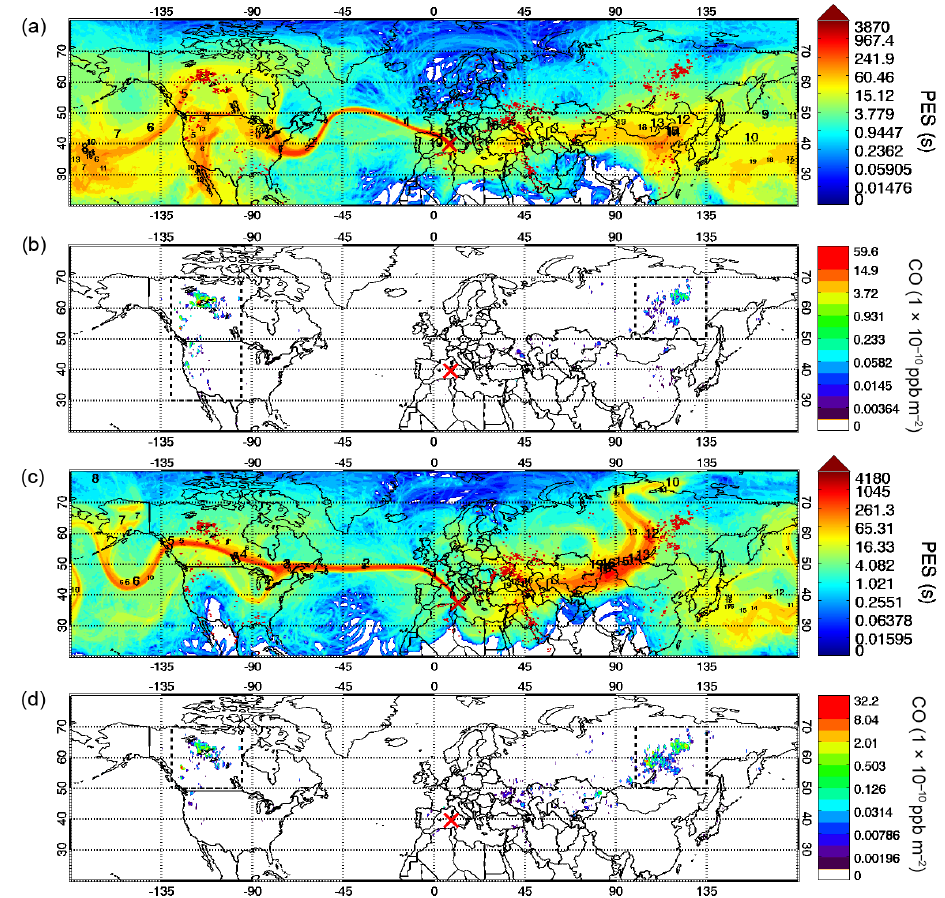
Figure 2. (a, c) Potential emission sensitivity (PES) of the particles in the 0–10km footprint layer for 20-day backward simulations on 10 and 6 August 2014, respectively. Superimposed on panels (a, c) are the MODIS fire detection (dark red dots) and numbers corresponding to the days of back trajectories with label sizes scaled according to the number of particles belonging to each cluster. The red crosses symbolize the location of the aircraft when measuring the peak of pollution. (b, d) CO biomass burning contribution calculated in the 0–10km PES layer on 10 and 6 August 2014, respectively. The dotted rectangles represent the masks used to see the specific contribution of Siberia and the North American continent in panel (b) and of Siberia and Canada in panel (d)